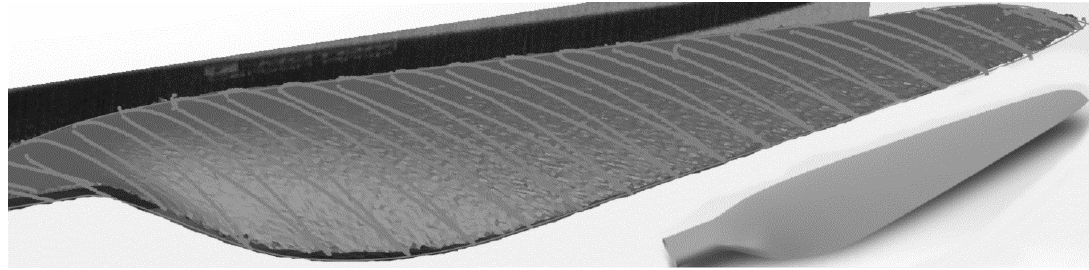
Figure 4. 3D scanned T-Motor 16 inch × 5.4 inch surfaces with recreated airfoil shapes.